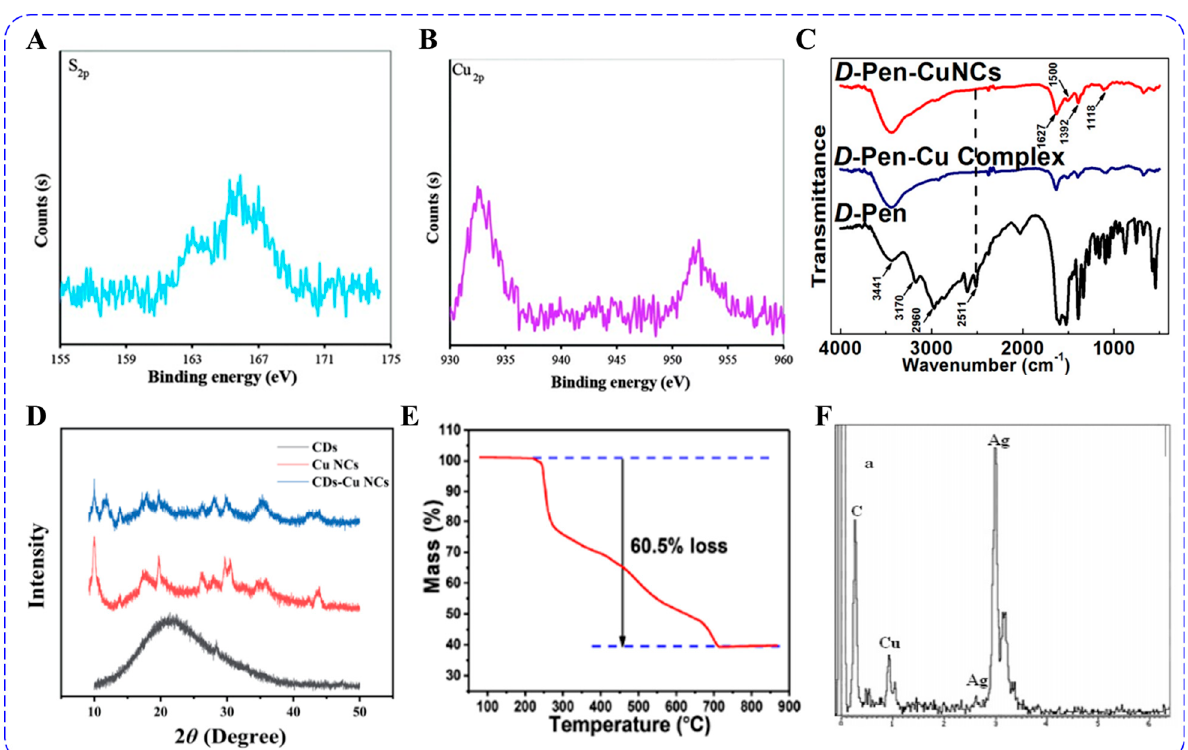
Figure 5. High-resolution XPS spectra of Cu 2p ( A ) and S 2p ( B ) of BSA/DPA-CuNCs [60], Copyrights from Royal Society Chemistry, 2016. ( C ) FT-IR spectra of D-Pen-CuNCs and other controls [61], Copyrights from Royal Society Chemistry, 2016. ( D ) XRD spectra of CDs-CuNCs and other controls [62], Copyrights from Royal Society Chemistry, 2021. ( E ) TGA curve of MMI-CuNCs [53], Copyrights from American Chemistry Society, 2022. ( F ) EDX spectrum of Ag-CuNCs [64], Copyrights from Elsevier, 2021.